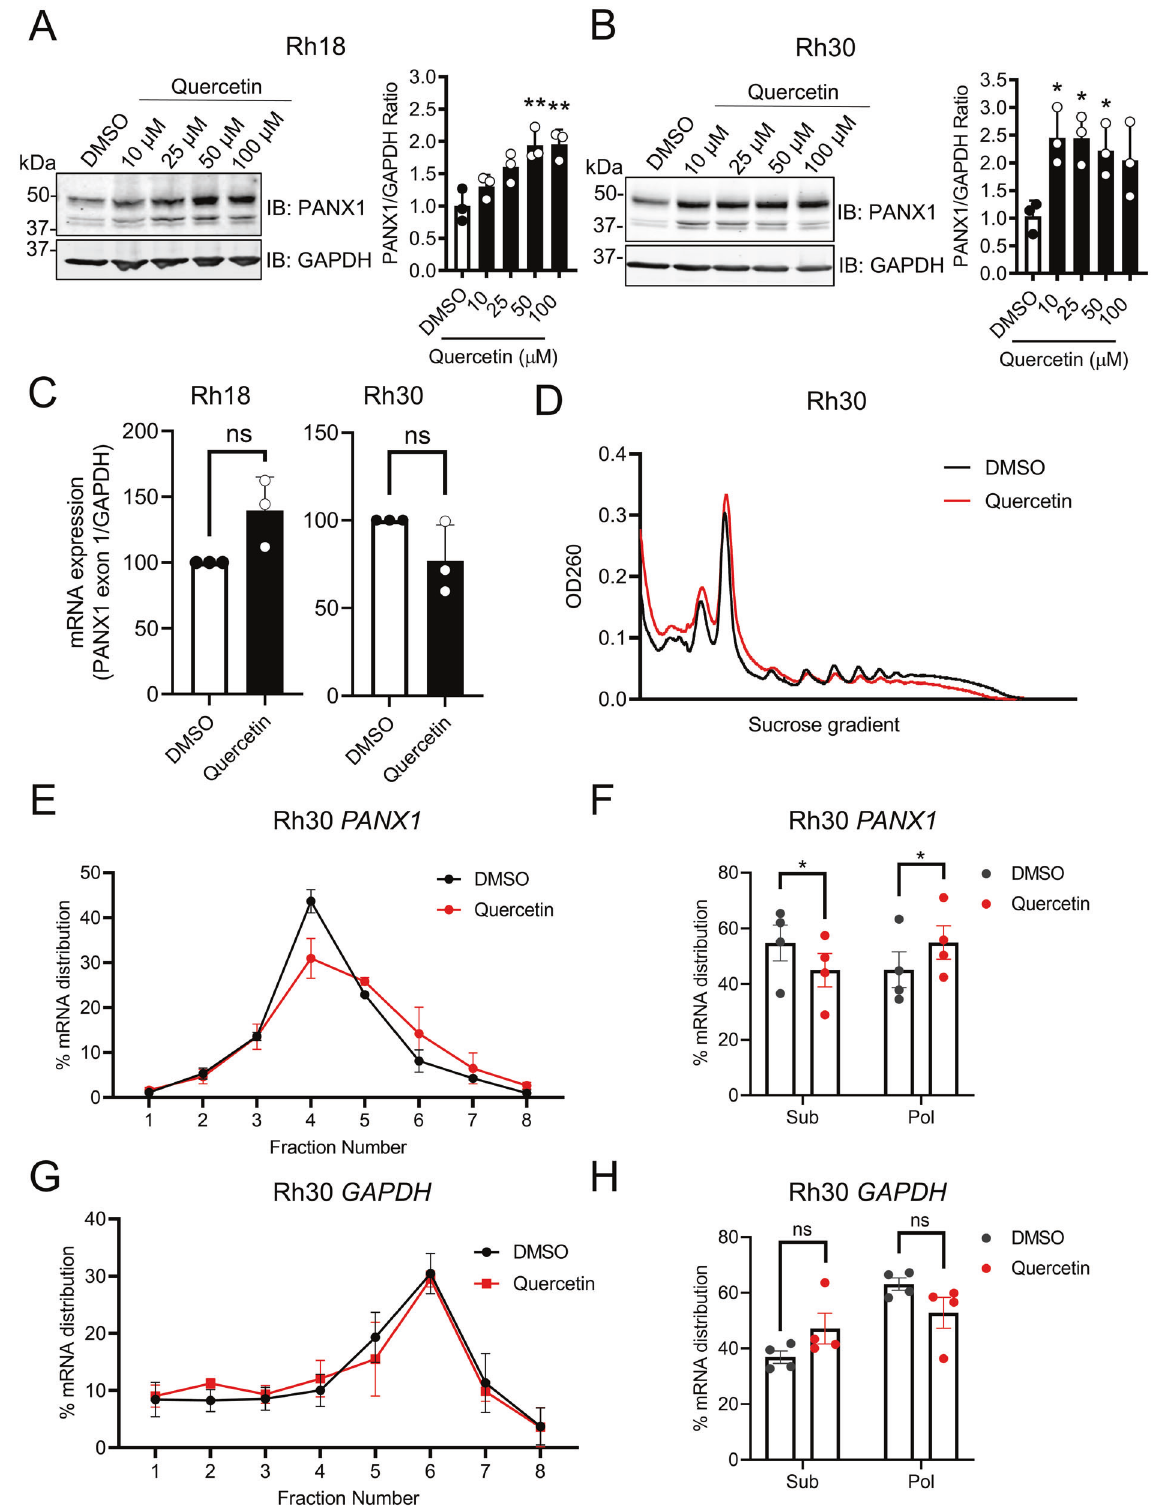
RESULTS PANX1 5 ’ UTR and protein levels are positively correlated in RMS and HSMM Unexpectedly, the RNA-sequencing (RNA-seq) result from